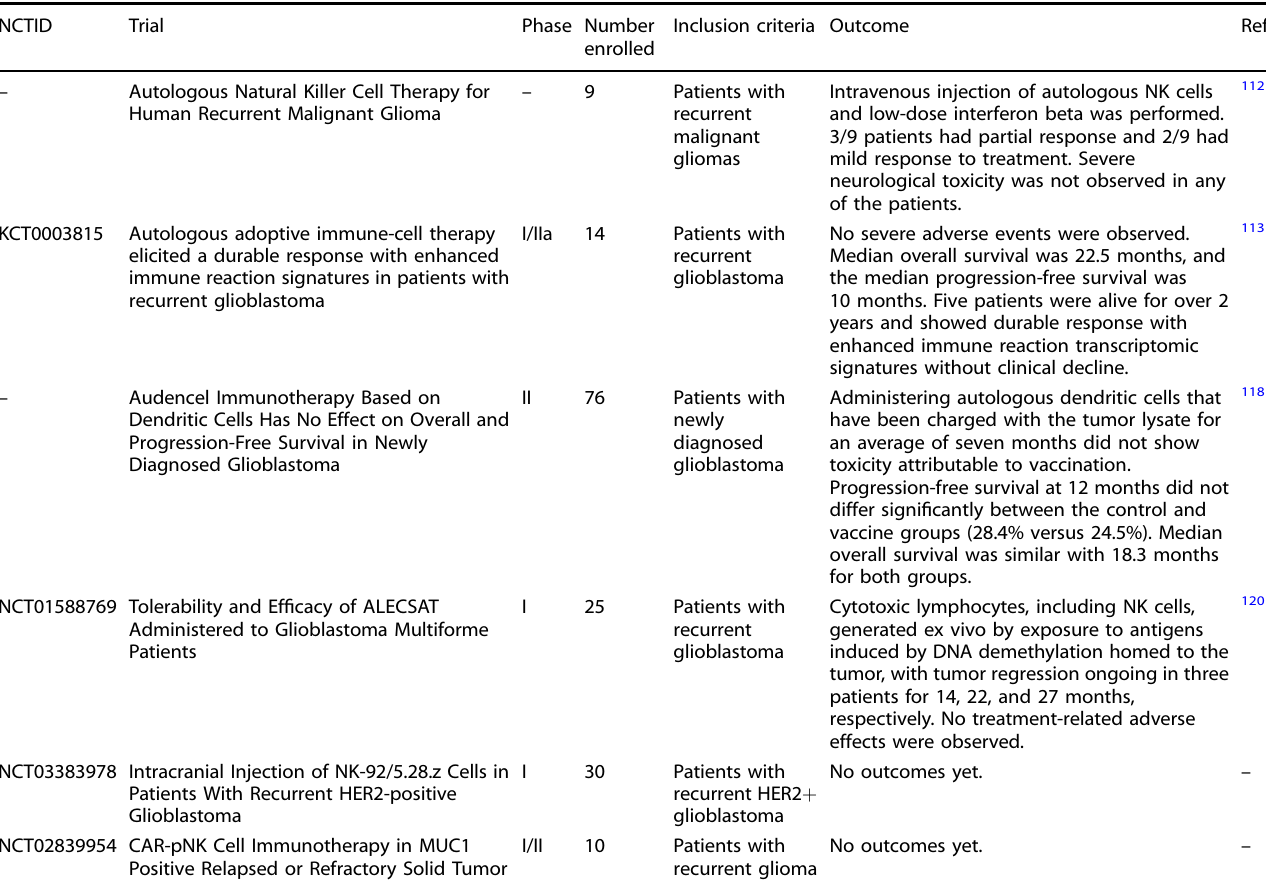
Table 3. Clinical trials using NK cell therapies for adult brain